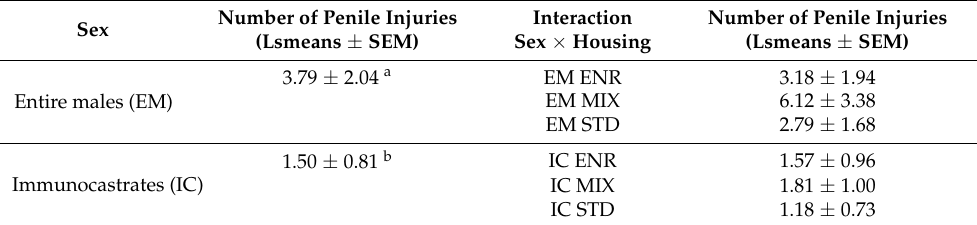
Table 3. Number of penile injuries per animal (Lsmeans ± SEM) for sex categories entire males (EM, n = 48) and immunocastrates (IC, n = 48) and the interaction of sex and housing (ENR = enriched: n = 12; MIX = mixing: n = 24; STD = standard: n = 12 per sex category).